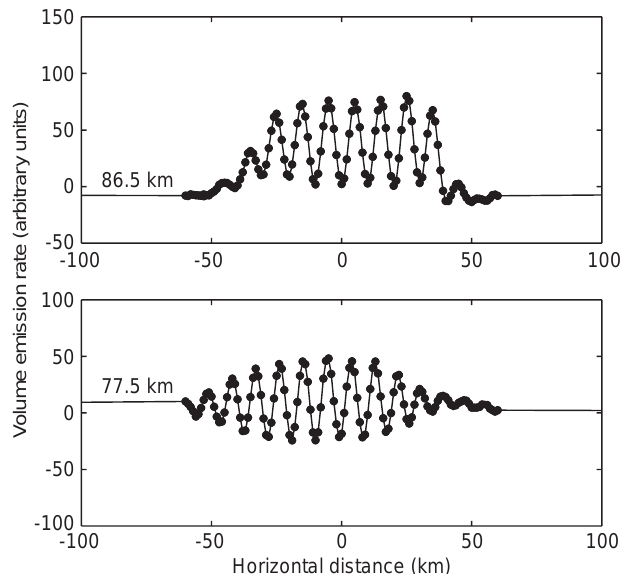
Fig. 5. Horizontal scans of the first inversion in Fig. 3b from altitudes 77.5 and 86.5 km